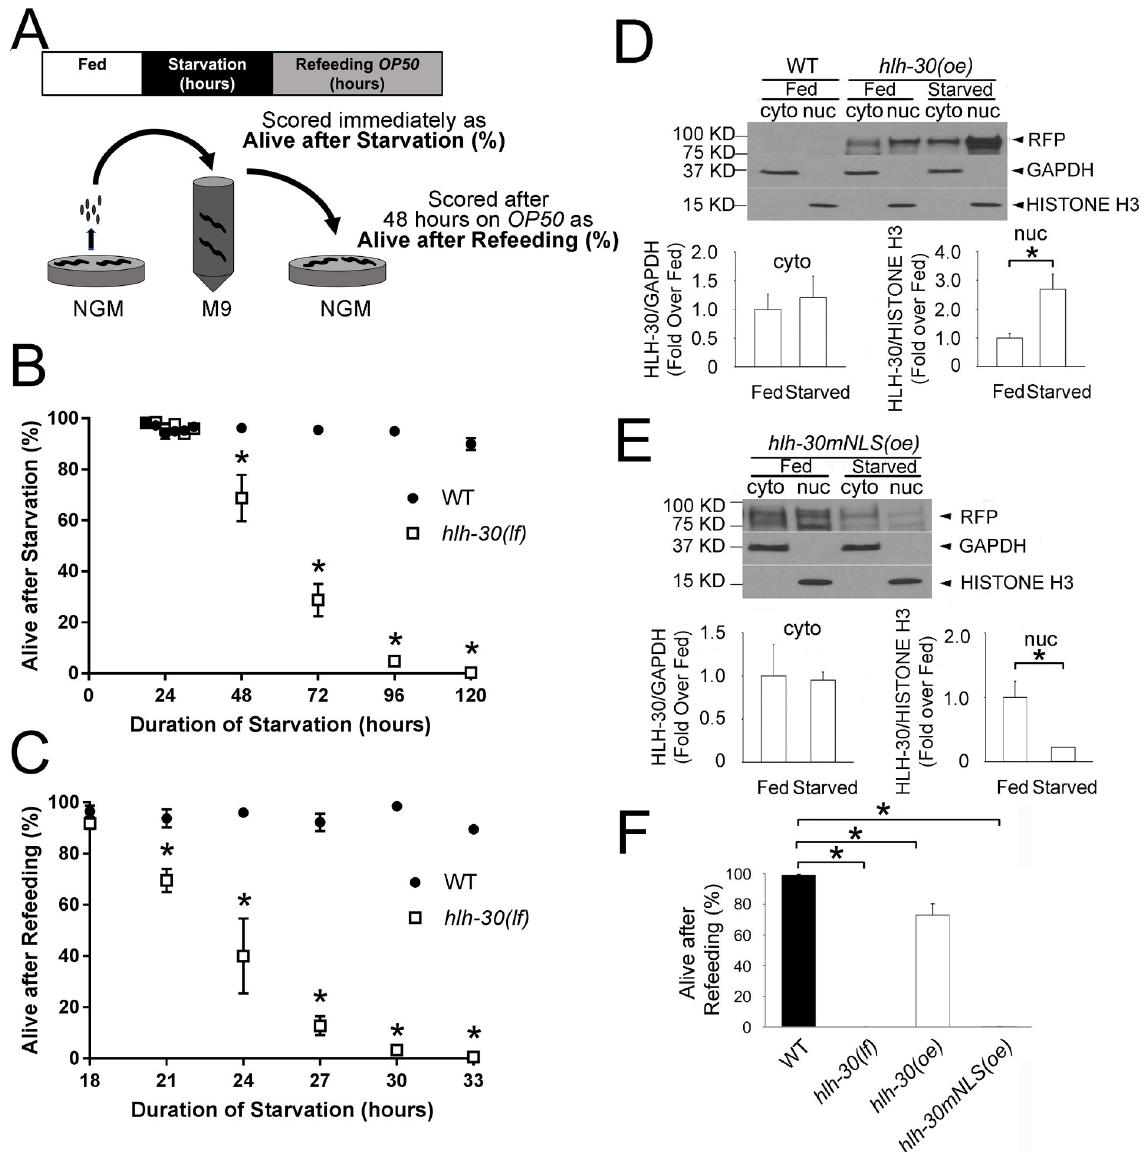
Fig 1. hlh-30 was necessary for survival during starvation and upon refeeding, and starvation promotes HLH-30 nuclear localization. (A) Schematic depicting starvation and refeeding assay. Gravid adults were bleached with alkaline hypochlorite to obtain eggs, which were transferred to buffered salt solution (M9). Upon hatching, larvae arrest development at the L1 stage. Aliquots of starved L1 worms were placed on NGM dishes seeded with E . coli ( OP50 ), and worms were immediately scored as alive or dead based on spontaneous movement; the fraction alive were defined as “Alive After Starvation.” After two days, worms were again scored as alive or dead based on spontaneous movement; the fraction alive compared to two days previously were defined as “Alive After Refeeding.” Because “Alive After Starvation” and “Alive After Refeeding” are calculated using different denominators, either value may be higher. (B, C) WT and hlh-30(lf) worms were analyzed after variable periods of starvation ( N = 4 biological replicates with 50 worms/time point; values indicate mean ± SEM). � P < 0.05 by post hoc test for comparison between the two genotypes at the indicated time points following two-way ANOVA. (D, E) Animals that overexpress RFP fused to WT hlh-30(oe) or to hlh-30(mNLS)(oe) were analyzed at the L1 stage in the fed state or after 33 hours of starvation. Protein extracts were separated to obtain cyto and nuc fractions. Representative immunoblots (above) illustrate protein levels, and quantification of HLH-30 levels in the cytosol (normalized to GAPDH levels, fed state set equal to 1.0) and nucleus (normalized to Histone H3 levels, fed state set equal to 1.0) are shown below. N = 3 biological replicates/group. Bars indicate mean ± SEM. � P < 0.05 by t test. Lanes 1 and 2 of the immunoblot in panel D contain extracts from WT worms lacking RFP expression and document the specificity of RFP detection. (F) WT, hlh-30(lf) , hlh-30(oe) , and hlh- 30(mNLS)(oe) worms were analyzed after 33 hours of starvation for “Alive after Refeeding.” N = 3 biological replicates/group of approximately 50 worms. Bars indicate mean ± SEM. � P < 0.05 by post hoc test after one-way ANOVA. Raw data for B–F are in S1 Data. cyto, cytoplasmic; GAPDH, glyceraldehyde 3-phosphase dehydrogenase; hlh-30 , basic helix–loop–helix transcription factor 30; hlh-30(mNLS)(oe) , overexpressed